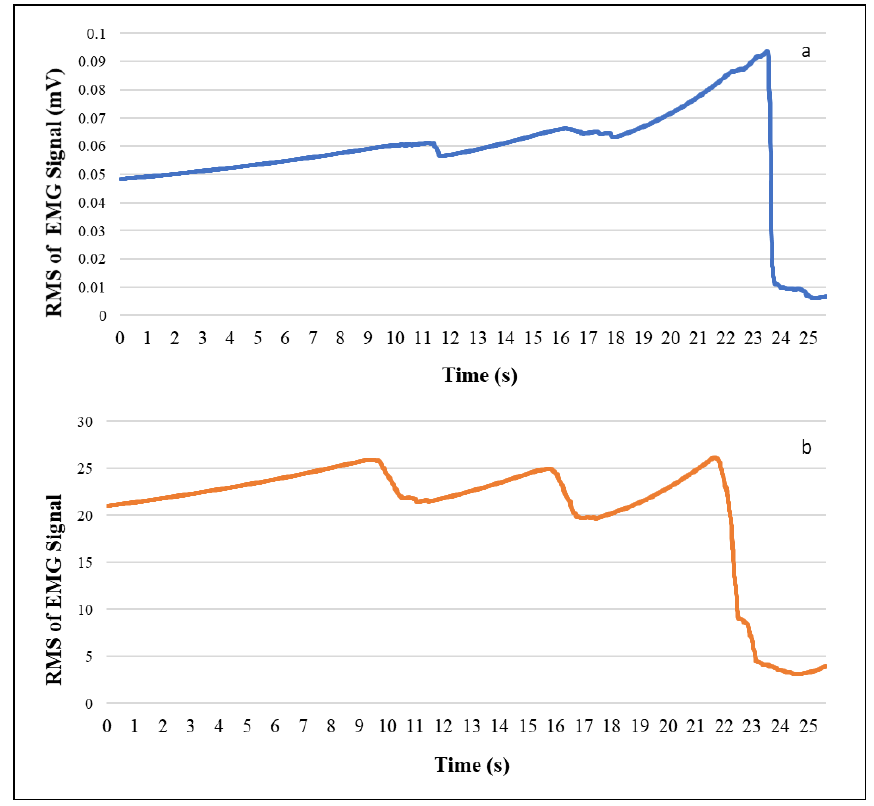
Figure 6 . EMG RMS plots for lifting activity using ( a ) conventional EMG sensor and ( b ) armband sensor.